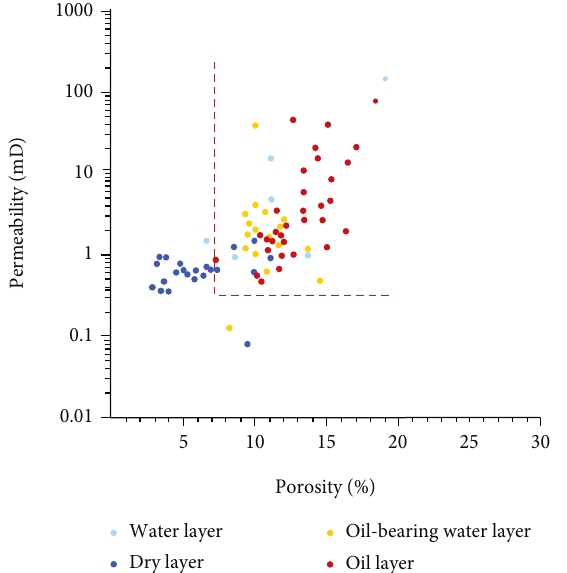
Figure 20: The plot of porosity versus permeability for sandstones with di ff erent